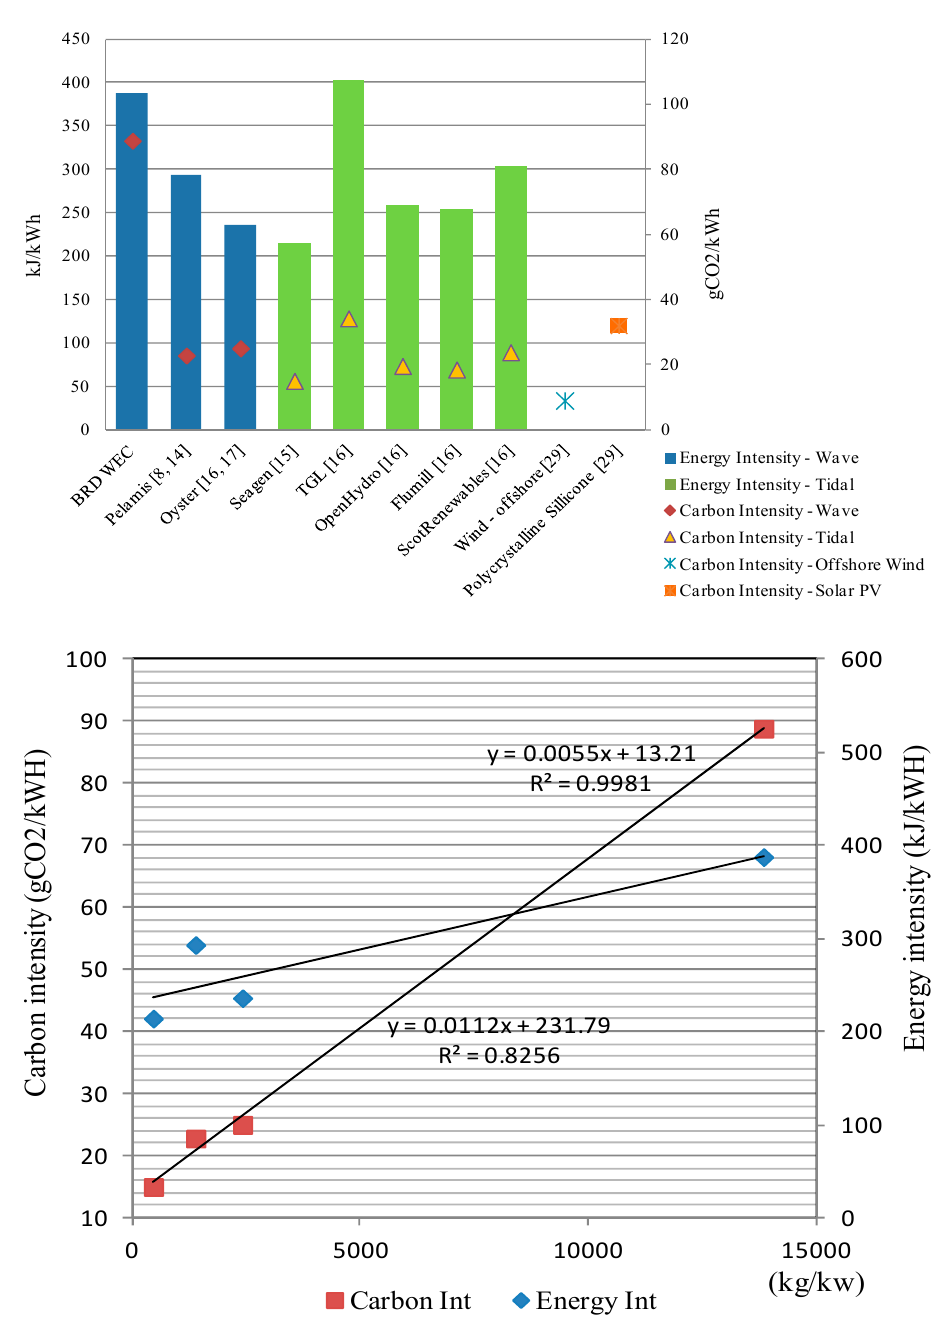
Figure 4. Energy and carbon intensities of WECs, comparison and vs. specific mass.